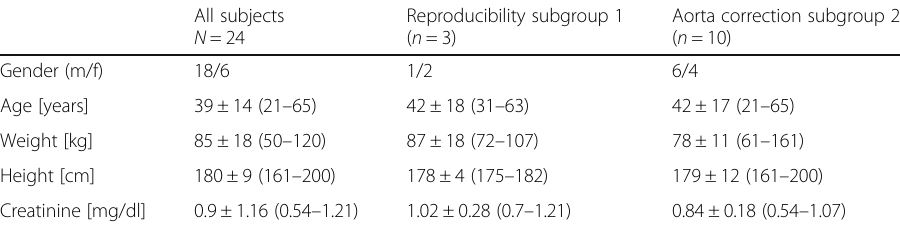
Table 1 Subject demographics: Basic subject data presented as mean value ± standard deviation; range from minimum to maximum value in parentheses. Subject group 1 was selected